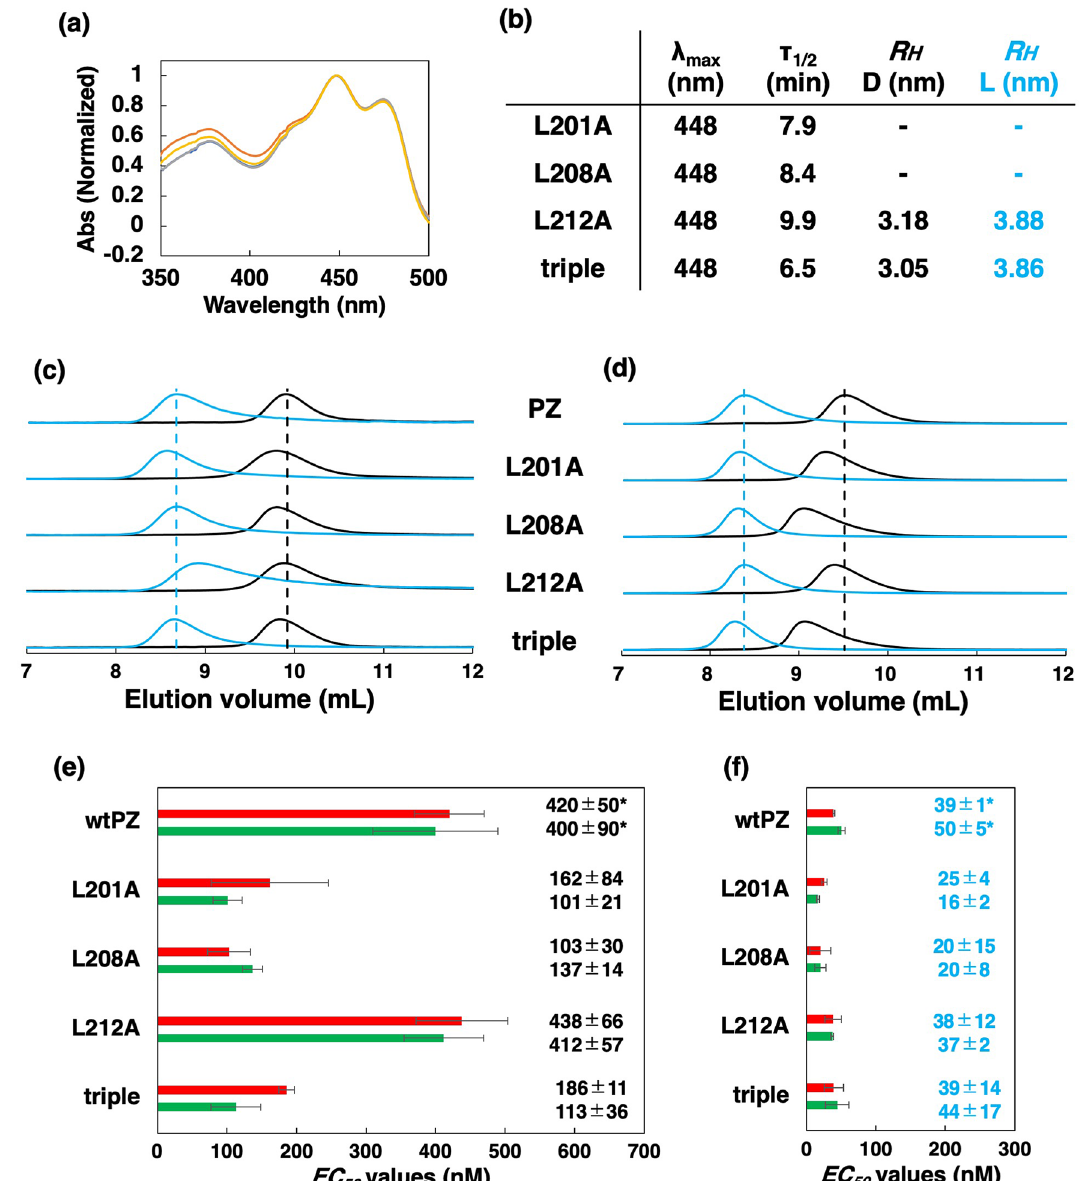
Figure 5. ( a ) Normalized absorption spectra of the A’α mutants. ( b ) λ max in the D state and τ 1/2 values of dark regeneration with R H values of the L212A and triple mutant in the D and L states. Elution profiles of the A’α mutants in the D (black lines) and L (blue lines) states, monitored at 280 nm at injected protein concentration of ( c ) 8 µM or ( d ) 50 µM. Black and blue dashed vertical lines indicate the peak volumes of wtPZ in the D and L states, respectively. The EC 50 values of the A’α mutants for dsApo according to EMSA (red bars) and QCM (green bars) in the ( e ) D and ( f ) L states with error bars (n ≥ 3). Numbers indicate EC 50 values and standard deviations (nM). *Data for wtPZ were taken from previous studies 15,16